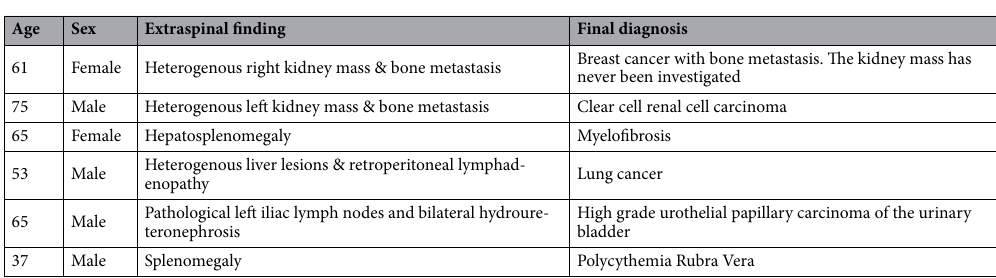
Table 3. Extraspinal findings proved to be related to malignancy upon further